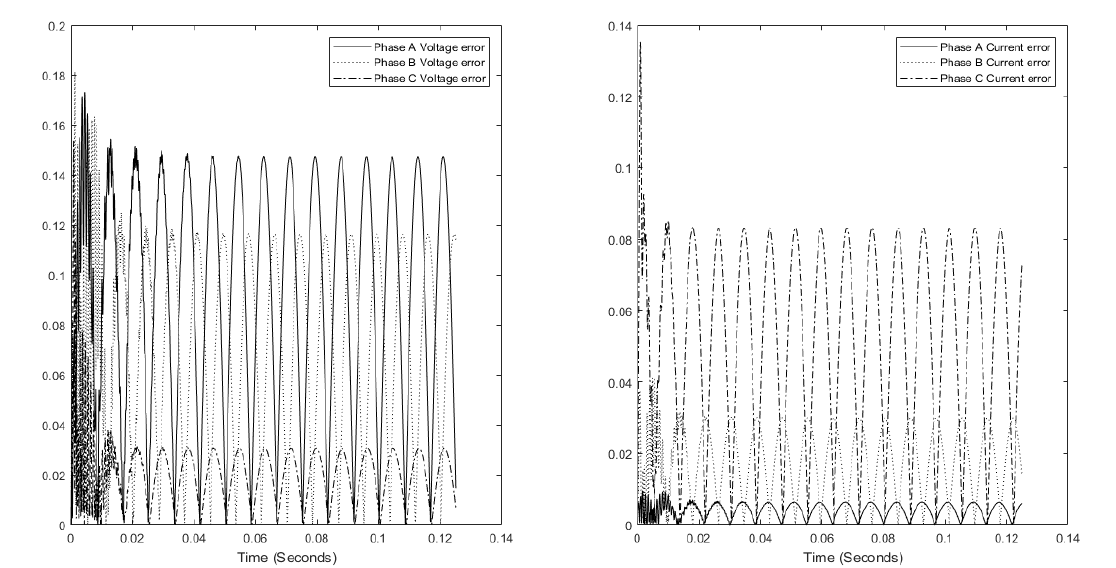
Figure 26. Simulink-hardware error results for second test